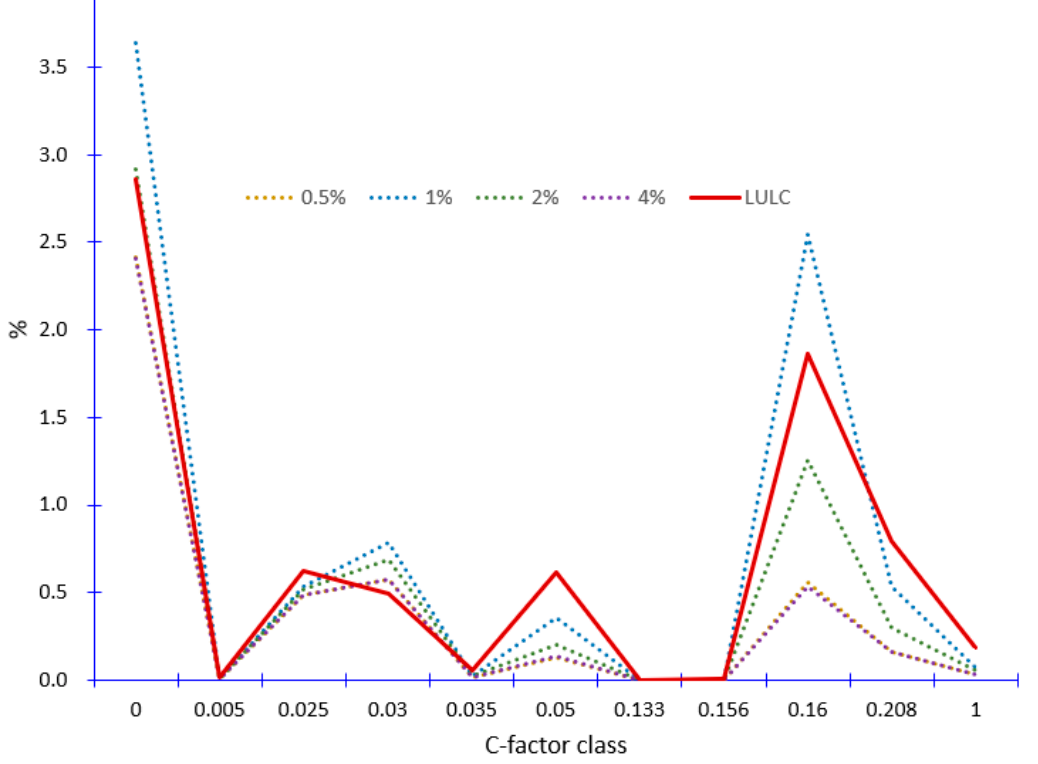
Figure 7. The model predicted percentage compositions of the minority classes in the 2004 population dataset under different sampling rates of the majority class. The red line indicates the true percentage composition from the 2004 official LULC map.